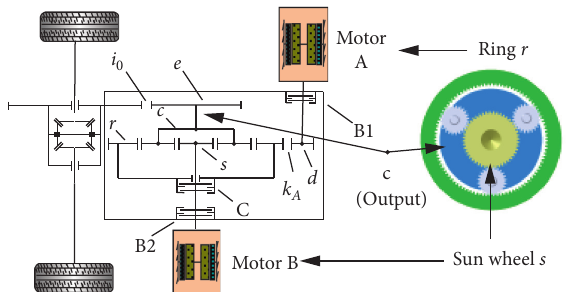
Figure 1: The diagrammatic sketch of dual-drive powertrain for pure electric